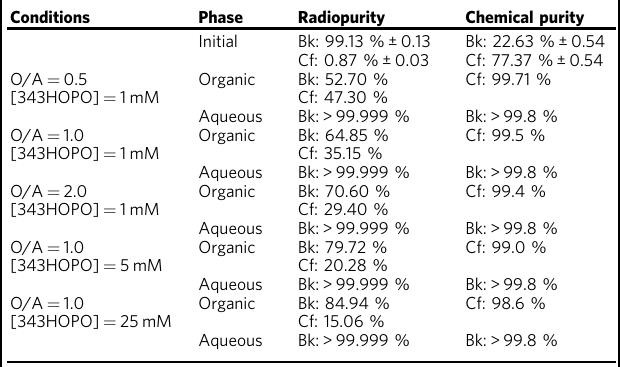
a Separation conditions: 0.1M TODGA in kerosene; 343HOPO in 3M HNO 3 . T = 25°C. One contact. Activity level: 2mCimL − 1 (74 GBq L − 1